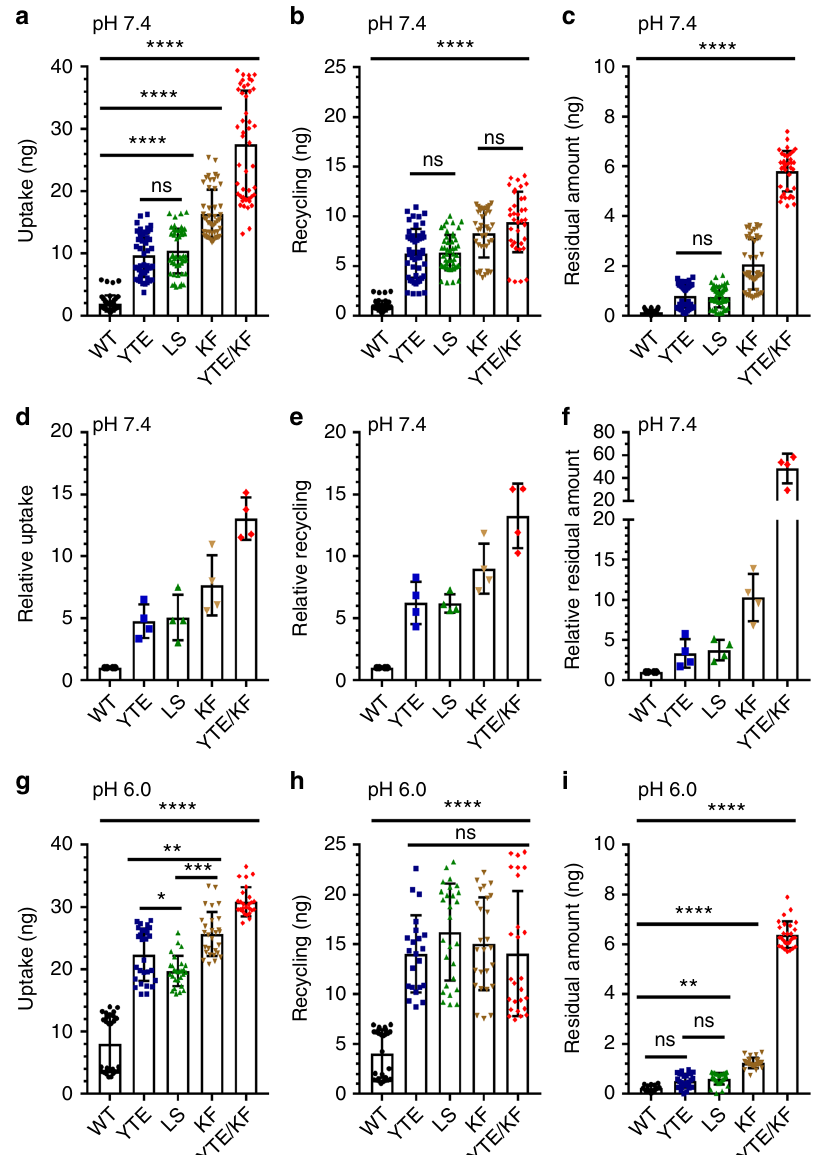
Fig. 5 HERA screening of WT and Fc-engineered hIgG1 variants. a Uptake of WT and Fc-engineered hIgG1 variants at pH 7.4 when 400 nM of each variant was added to the cells followed by 4 h incubation, washing and lysis of the cells. b Recycling of the Fc-engineered hIgG1 variants at pH 7.4 when 400nM of each variant was added to the cells and incubated for 4 h followed by extensive washing and additional 4 h incubation before sample collection. c The same procedure as in b followed by lysis of the cells. The amounts of hIgG variants in all samples were quanti fi ed by ELISA and obtained data are shown as mean ± s.d. of four independent experiments performed in triplicates. ns > 0.05, **** p < 0.0001, by one-way ANOVA (Tukey ’ s multiple comparison test). Relative d uptake, e recycling and f residual amount calculated from data ( a – c ), g uptake, h recycling and i residual amounts when WT and the Fc- engineered hIgG1 variants were initially incubated at pH 6.0. The amounts of hIgG variants in all samples were quanti fi ed by ELISA, and obtained data are shown as mean ± s.d. of two independent experiments performed in triplicates. ns > 0.05, * p < 0.05, ** p < 0.01, *** p < 0.001 and **** p < 0.0001, by one- way ANOVA (Tukey ’ s multiple comparison